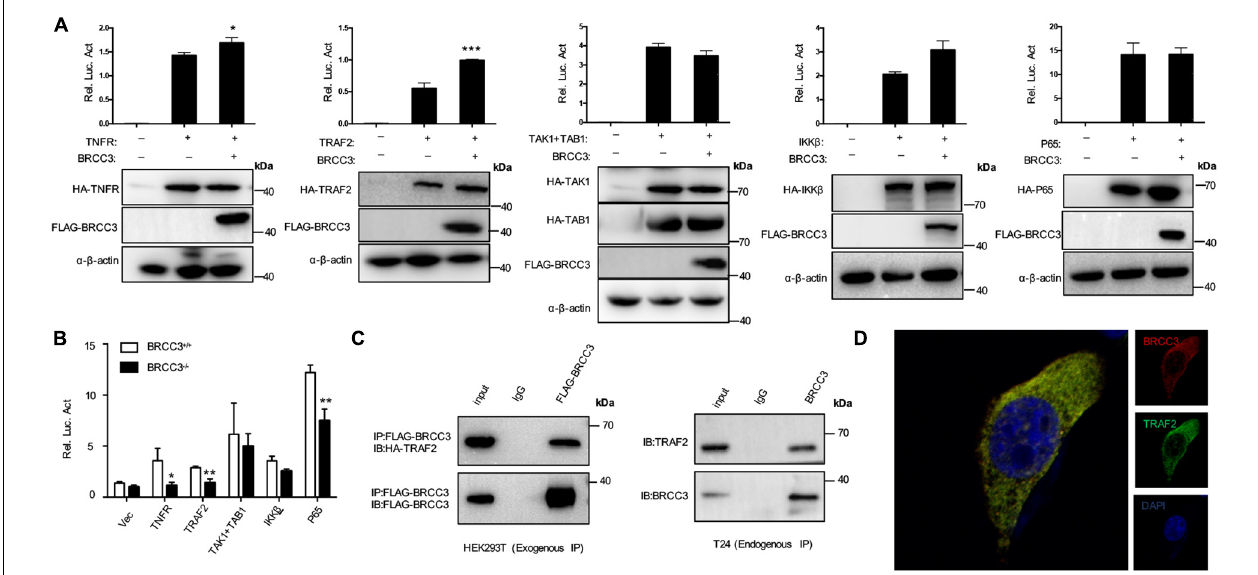
FIGURE 5 | BRCC3 activated the NF- κ B signaling pathway through TRAF2. (A) The synergistic effects of TNFR, TRAF2, TAK1, and TAB1, IKK β or P65 together with BRCC3 on NF- κ B transcriptional activation were evaluated. HEK293T cells were co-transfected with an NF- κ B reporter firefly luciferase plasmid (200 ng), pRL-TK (10 ng), the indicated component of an NF- κ B pathway (300 ng) and a BRCC3 plasmid (300 ng). Reporter assays were performed 48 h after transfection, and the results are presented as the NF- κ B/TK luciferase activity. Data were analyzed employing one-way ANOVA and are presented as the mean ± SE ( n = 3 per group). (B) The influence of endogenous BRCC3 on NF- κ B transcriptional activation induced by different NF- κ B pathway components including TNFR, TRAF2, TAK1 and TAB1, IKK β , and P65 was assessed. (C) BRCC3 interacted with TRAF2 in both exogenous and endogenous ways. The whole-cell extracts of HEK293T